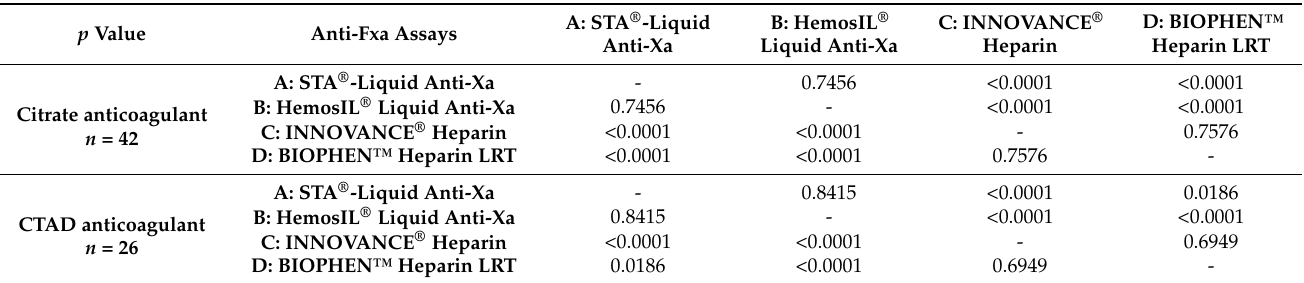
Table 2. p -values using the Friedman’s test for cross-comparison of the various assay-tested citrate ( n = 42) or CTAD ( n = 26) anticoagulated samples. The median of the populations at the 1% significance level are with p -values < 0.01 when the measured concentrations are not